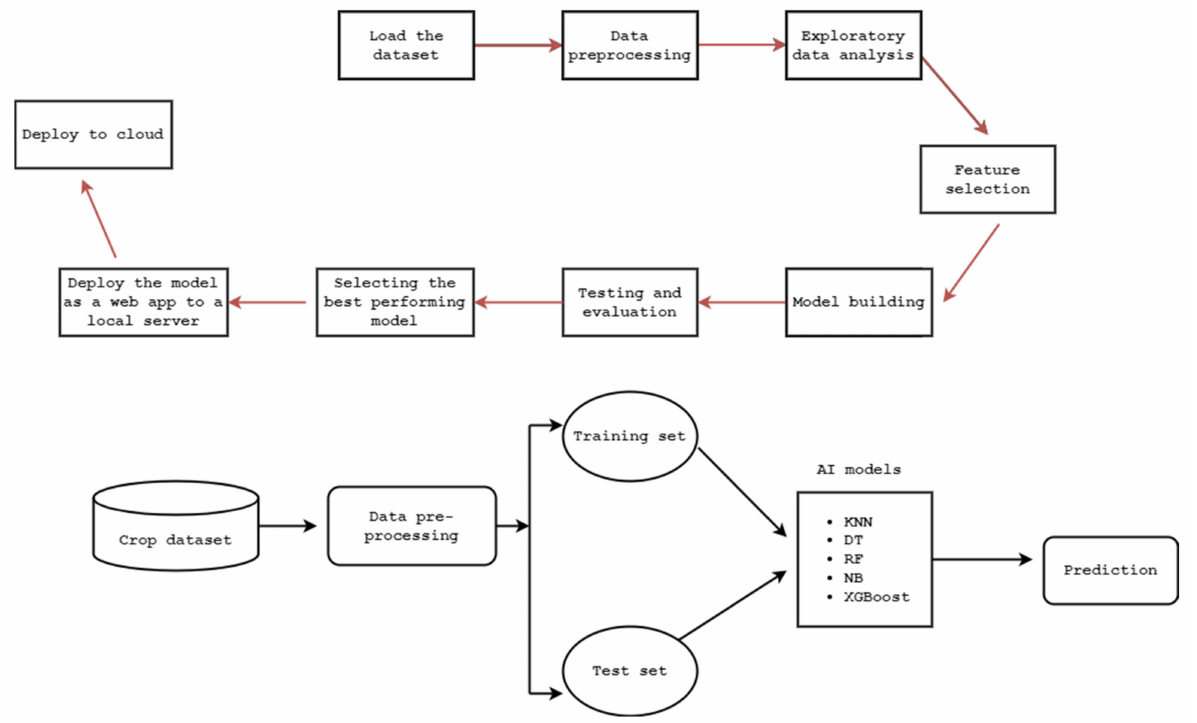
Figure 5. Steps involved in the design of the crop recommendation